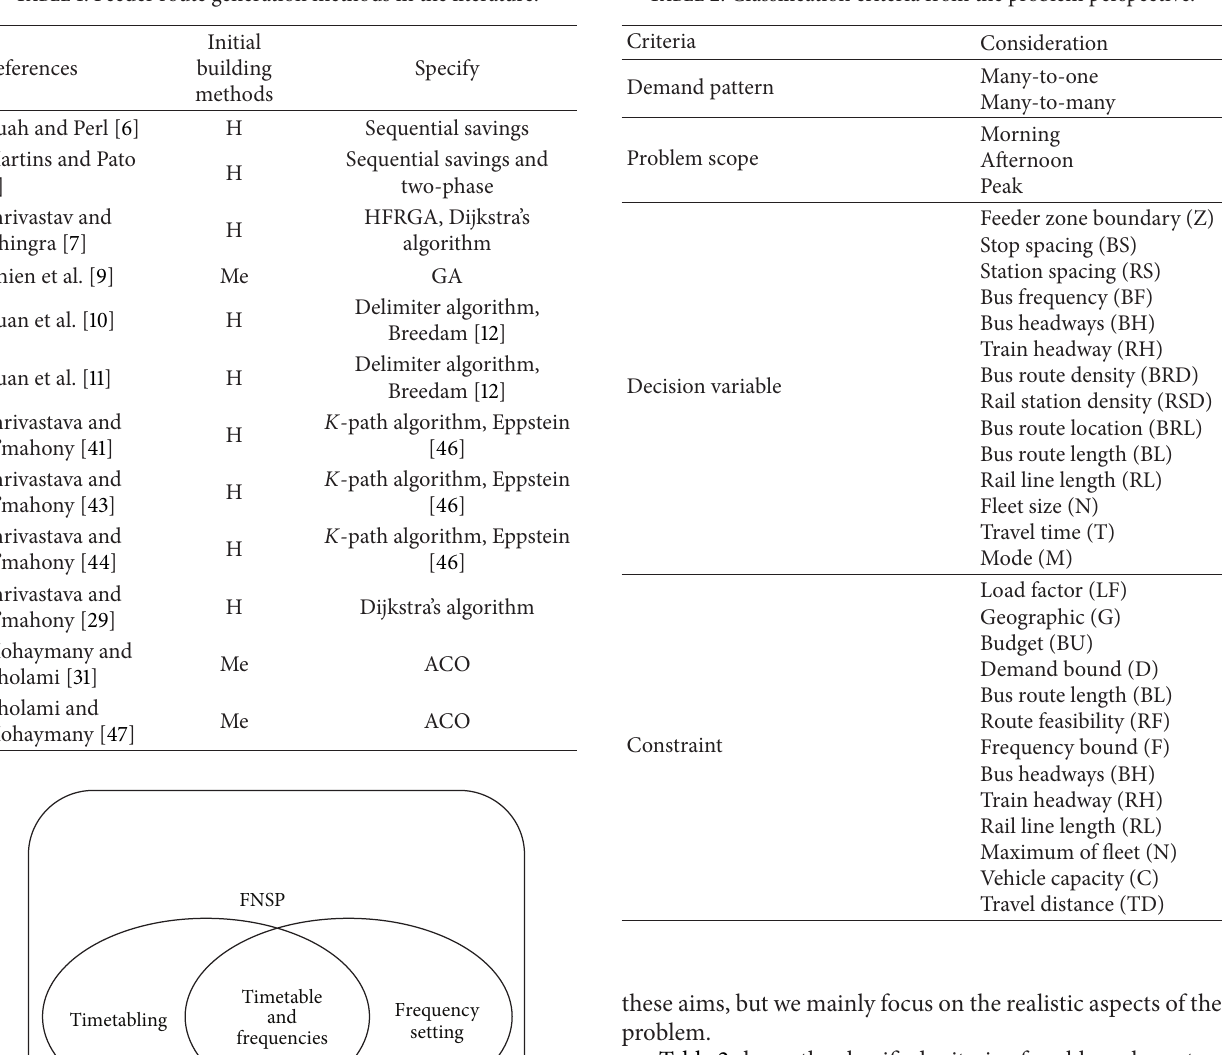
Table 1: Feeder route generation methods in the literature.